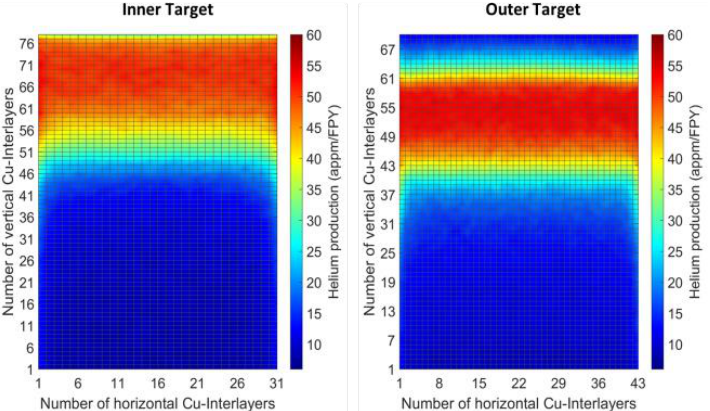
Figure 25. He-production (appm/FPY) distribution on Cu/CuCrZr components of the inner ( left ) and outer ( right ) target, with WCLL blanket.